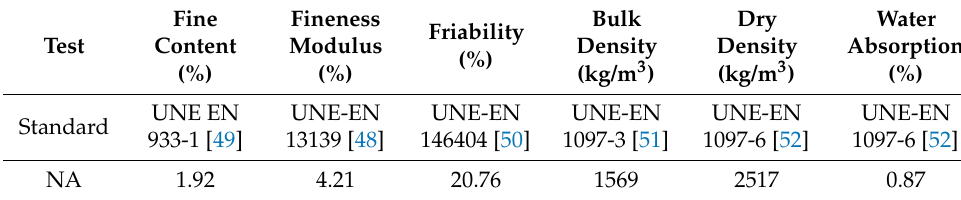
Table 2. Physical characterization of the natural river sand.